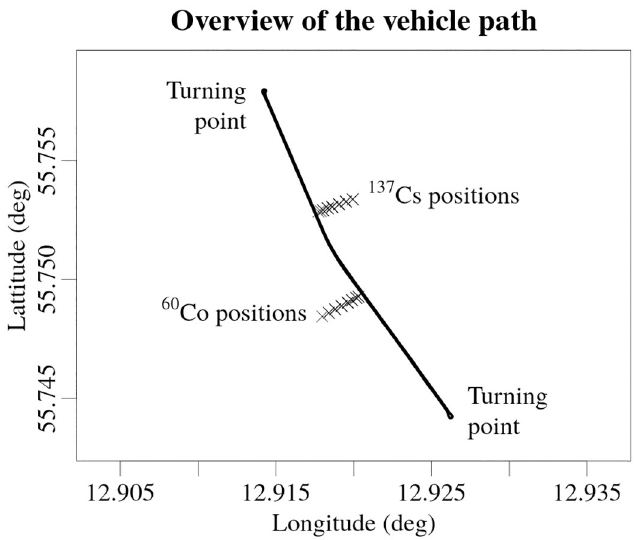
Fig 2. Illustration of the path of the vehicle and the positions of the radioactive sources. The symbol × marks all of the positions of the 137 Cs and 60 Co sources used in the experiment. The latitude and the longitude are geographic coordinates reported in accordance to World Geodetic System standard WGS